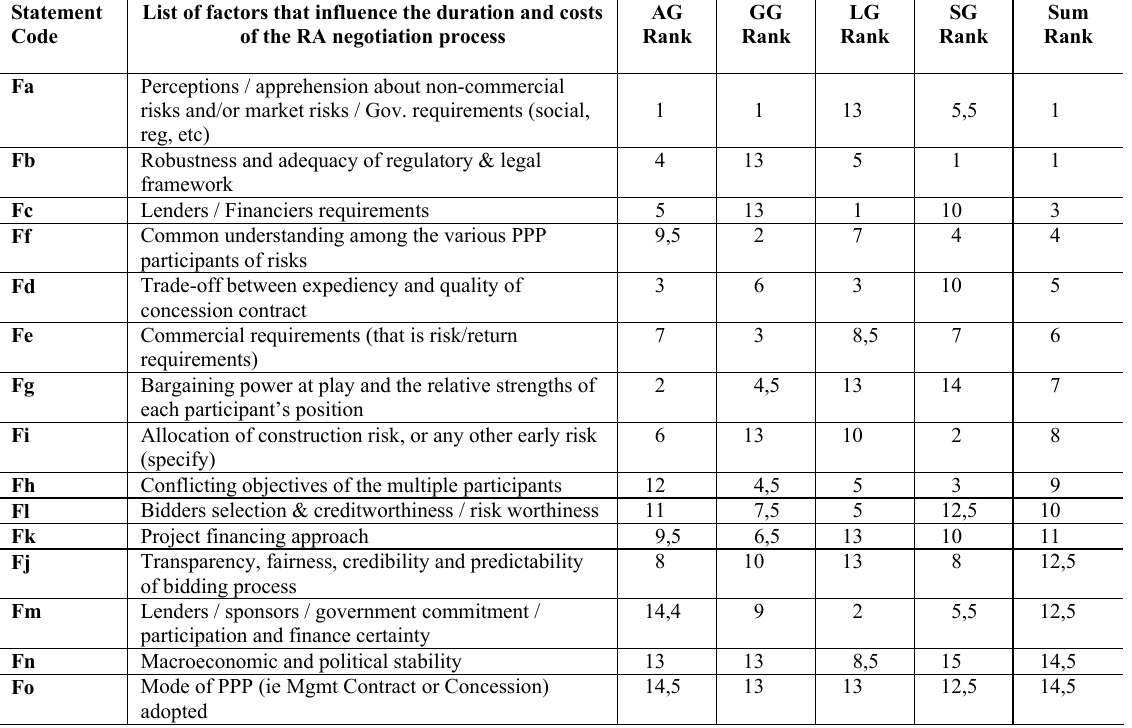
Table 4: Comparative ranking of critical factors Statement